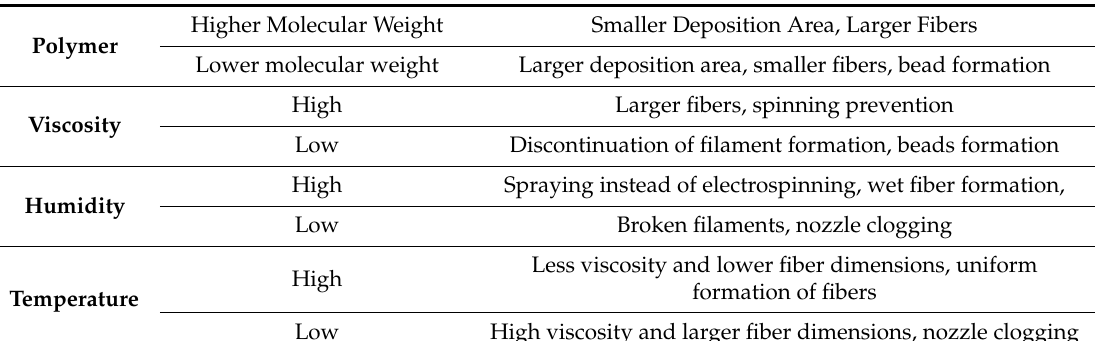
Table 2. Comparison study of spinnable polymers based on solvent and viscosity .